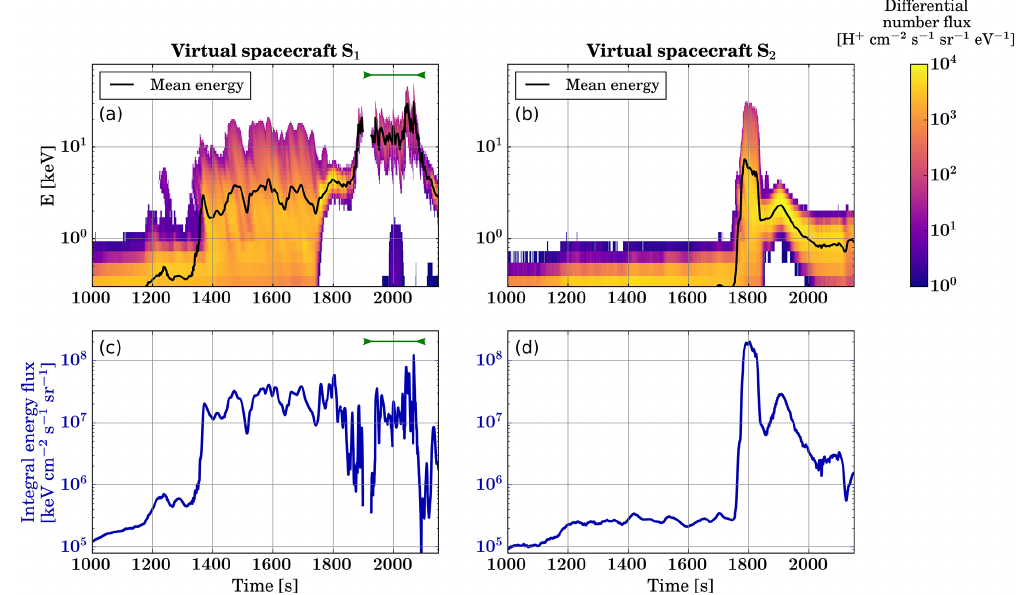
Figure 5. (a) Differential number flux of precipitating protons observed at virtual spacecraft S 1 as a function of time during the simulation. The black line indicates the mean precipitating energy as a function of time. (b) Same but at virtual spacecraft S 2 . (c) Integral energy flux associated with proton precipitation as a function of time at virtual spacecraft S 1 . (d) Same but at virtual spacecraft S 2 . The green segments in panels (a) and (c) indicate the time interval with precipitation associated with dipolarising flux bundles presented later.